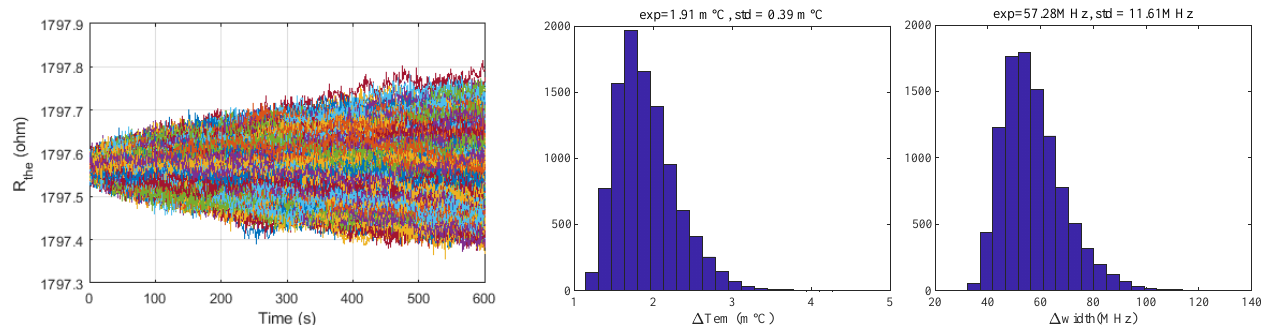
Figure 7. The trend and statistical chart of R the over 10 5 times, conducted by Monte Carlo simulation.